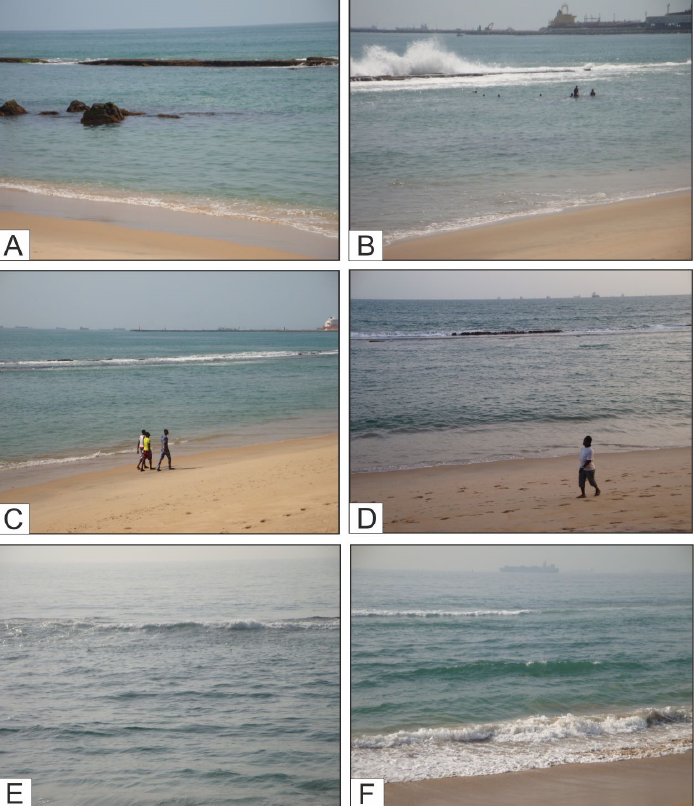
Figure 7. Submerged relief to the east of the port of Lomé, which emerges during the low tide as in ( A – D ) and disappears during the high tide ( E , F ). In ( B ) the eastern part of the port is visible. Observations carried out during the period 2014–2020 (photographs December 2019).